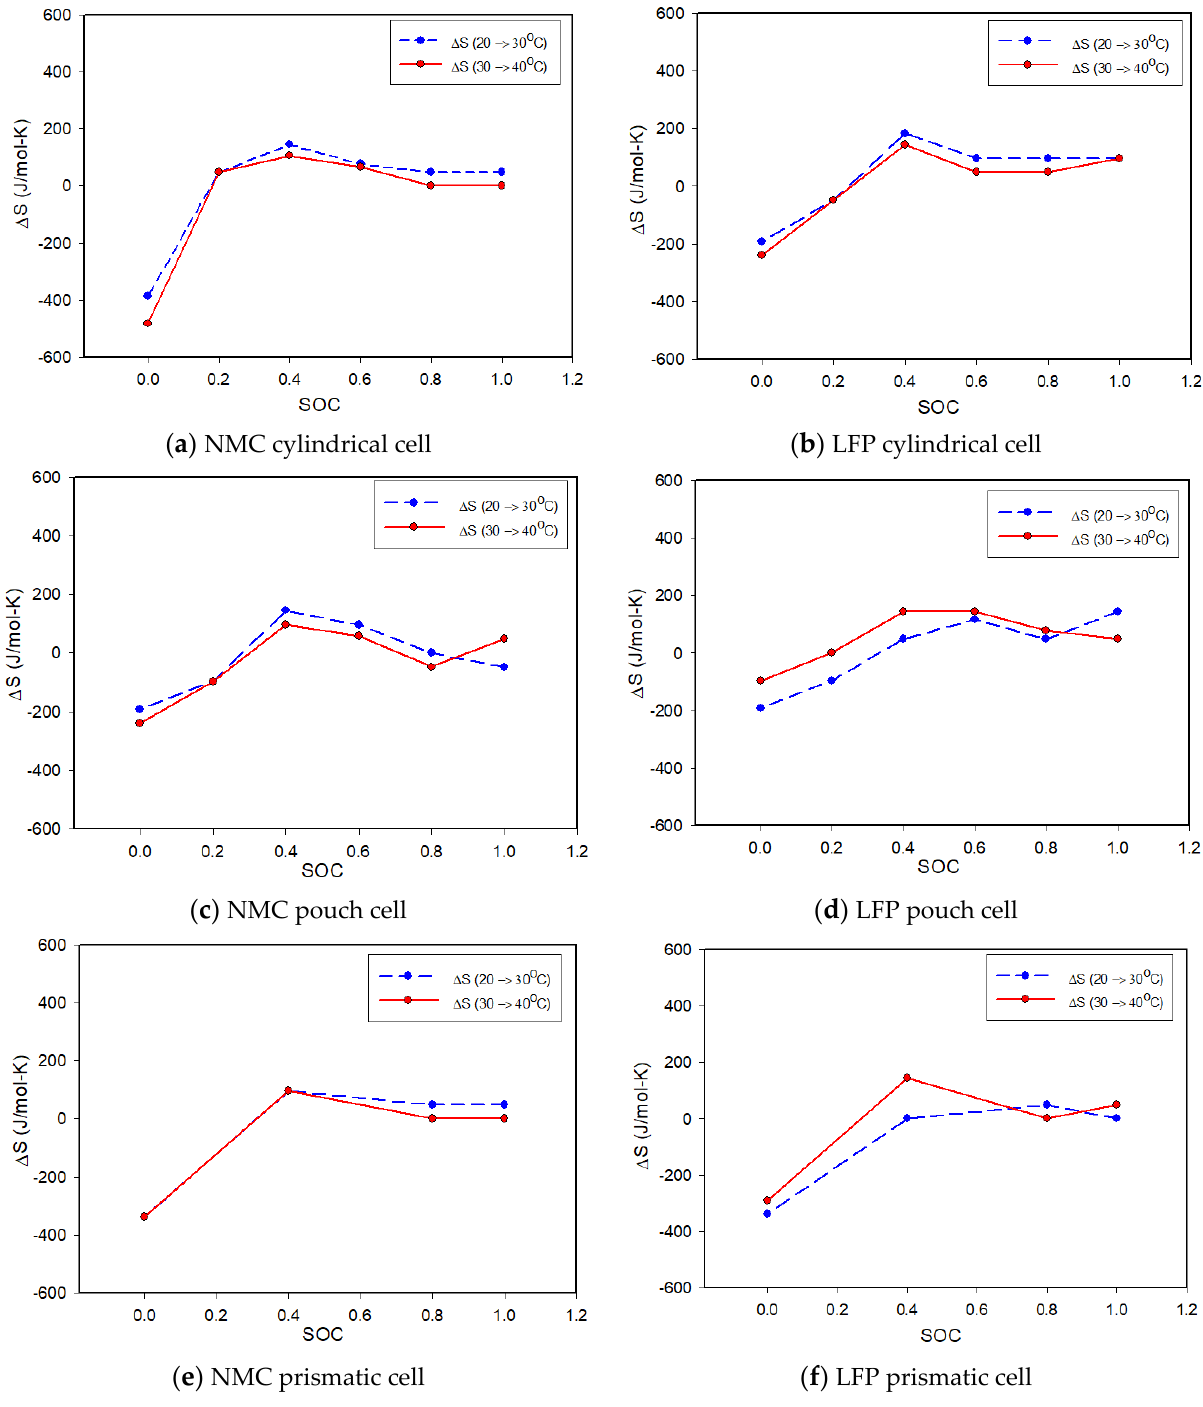
Figure 8. The entropy change of six batteries in various SOCs: ( a ) NMC cylindrical, ( b ) LFP cylindrical, ( c ) NMC pouch, ( d ) LFP pouch, ( e ) NMC prismatic, and ( f ) LFP prismatic.